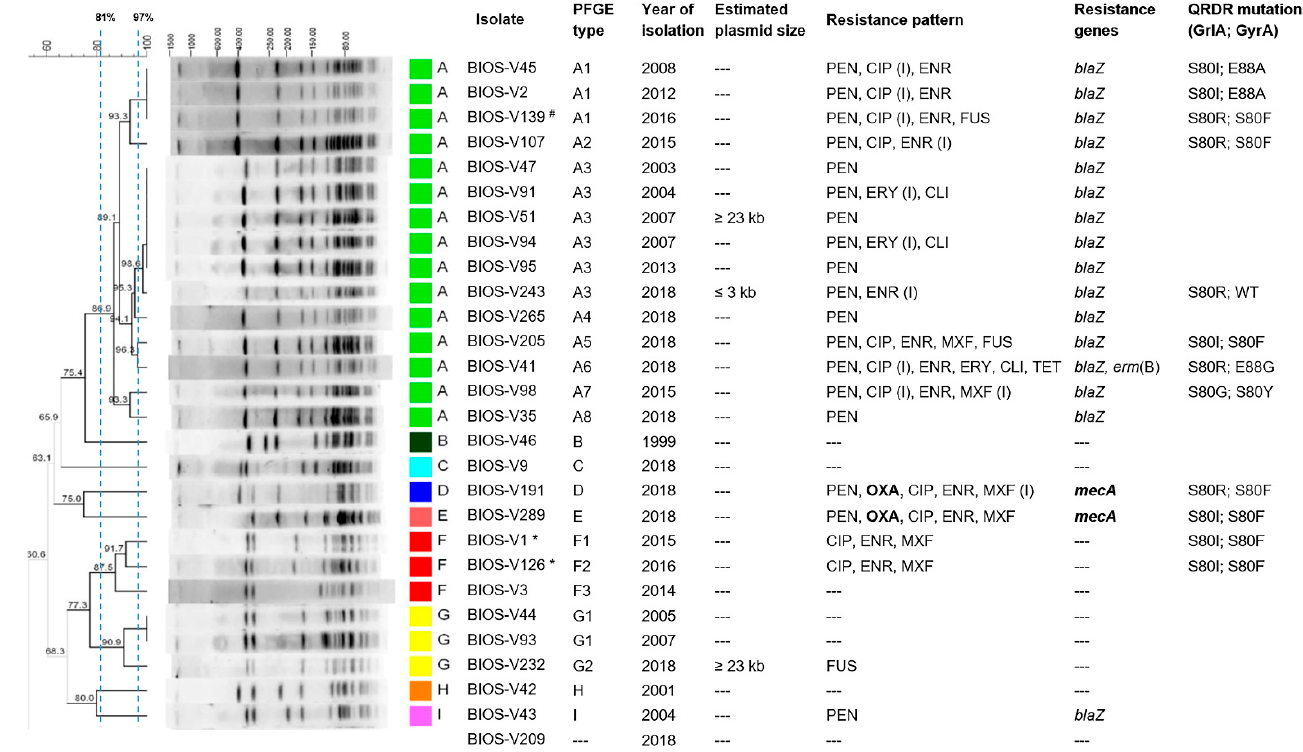
Figure 1. Sma I-PFGE macrorestriction profile analysis of the 27 S. coagulans and 1 S. schleiferi isolates associated with canine skin infections and their correlation with plasmid profiles, as well as their phenotypic and genotypic resistance traits. The symbol (#) indicates the S. schleiferi isolate. The symbol (*) highlights the two S. coagulans isolates collected from the same dog. The dendrogram was built using Bionumerics and the UPGMA algorithm, using the Dice coefficient, and an optimization of 0.5% and tolerance of band of 1%. The dashed lines correspond to the similarity criteria for considering isolates belonging to the same PFGE type ( ≥ 81%) or subtype ( ≥ 97%). PFGE: pulsed-field gel electrophoresis; PEN: penicillin; CIP: ciprofloxacin; ENR: enrofloxacin; MXF: moxifloxacin; ERY: erythromycin; CLI: clindamycin; FUS: fusidic acid; TET: tetracycline; (I) intermediate phenotype; QRDR: quinolone-resistance determining region; S: serine; I: isoleucine; E: glutamic acid; A: alanine; R: arginine; F: phenylalanine; G: glycine; Y: tyrosine; WT: